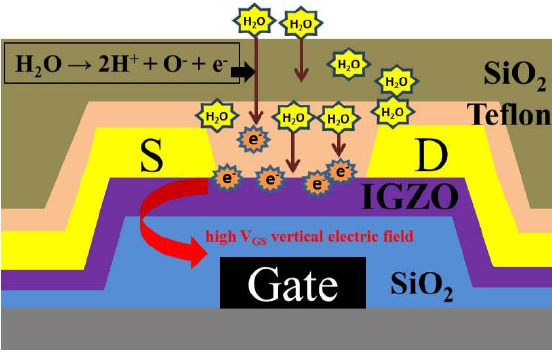
Figure 5. Schematic of H 2 O-molecule-induced extra electron carrier model for a-IGZO